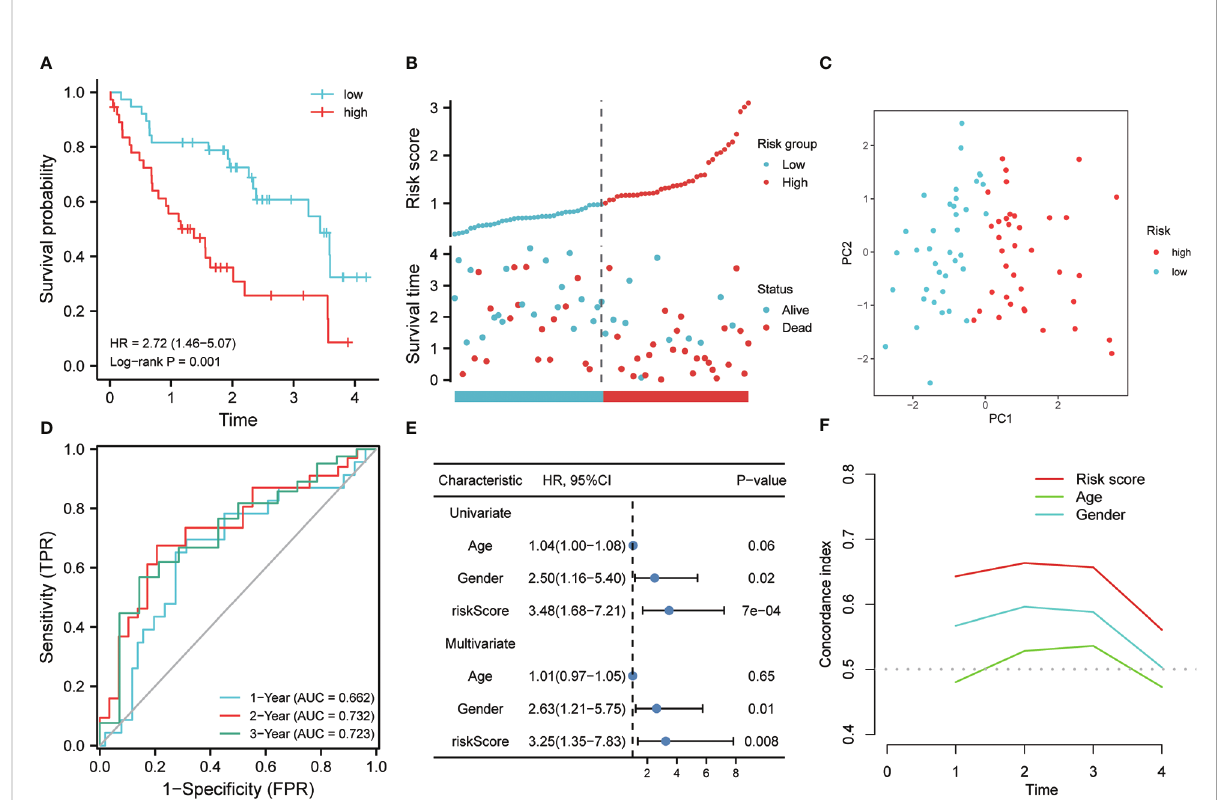
FIGURE 5 The effectiveness of the risk model was veri fi ed in the validation set. (A) K-M method was used to draw the survival curve based on risk score, and for comparison, a log-rank test was employed. (B) The distribution of RS and survival status between high and low-risk groups. (C) To evaluate the differentiation between groups with high and low-risk, PCA was utilized. (D) Through ROC analysis, the predictive role of the risk model in the validation cohort was evaluated. (E) Univariate and multivariate Cox analysis. (F) for the evaluation of the prediction ability of the model, C-index analysis was